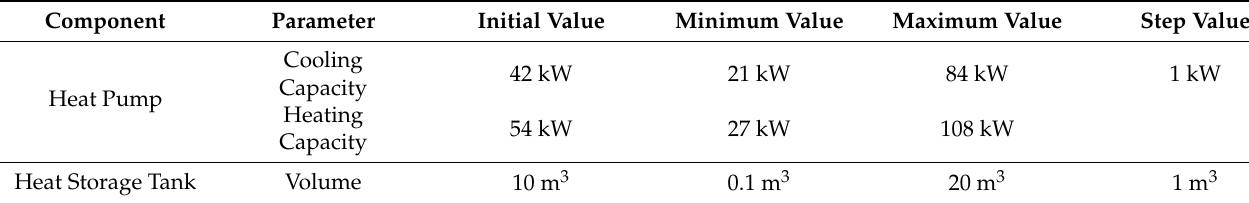
Table 4. Specification of optimization.